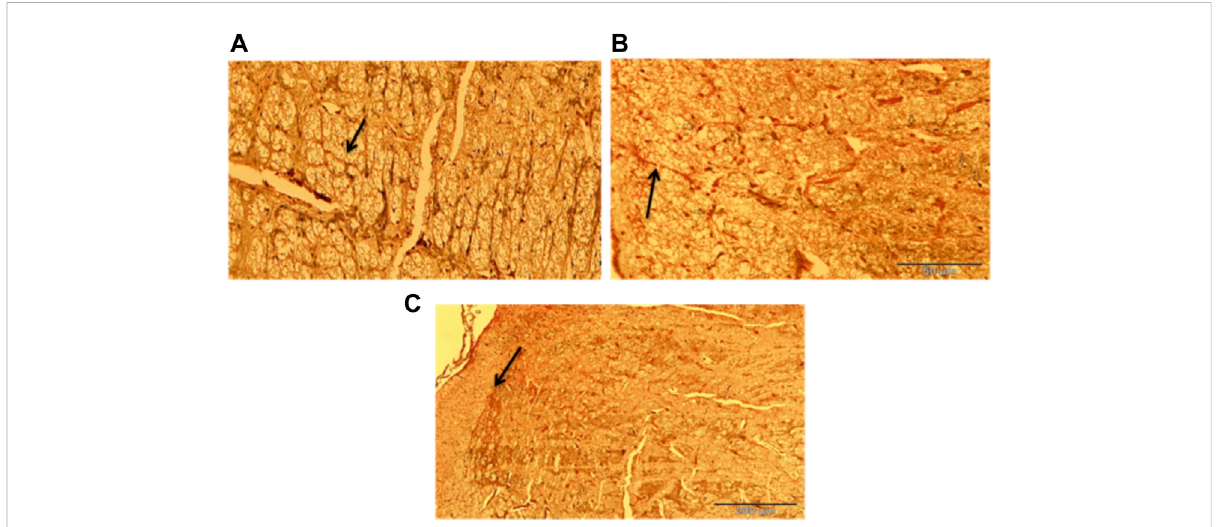
FIGURE 16 Photomicrographofthecerebrumof (A) Nontraumatizednontreated(GroupIII)showingnormalaxon(arrow), (B) Traumatizednontreatedrats (GroupII)showingaxonalbulb(Thinarrow)andaxonalbreak(Thickarrow), (C) DMSOtreatedrats(GroupI)groupshowingnormalizationoftheaxon (arrow) Belchowsky stain ×40 DMSO